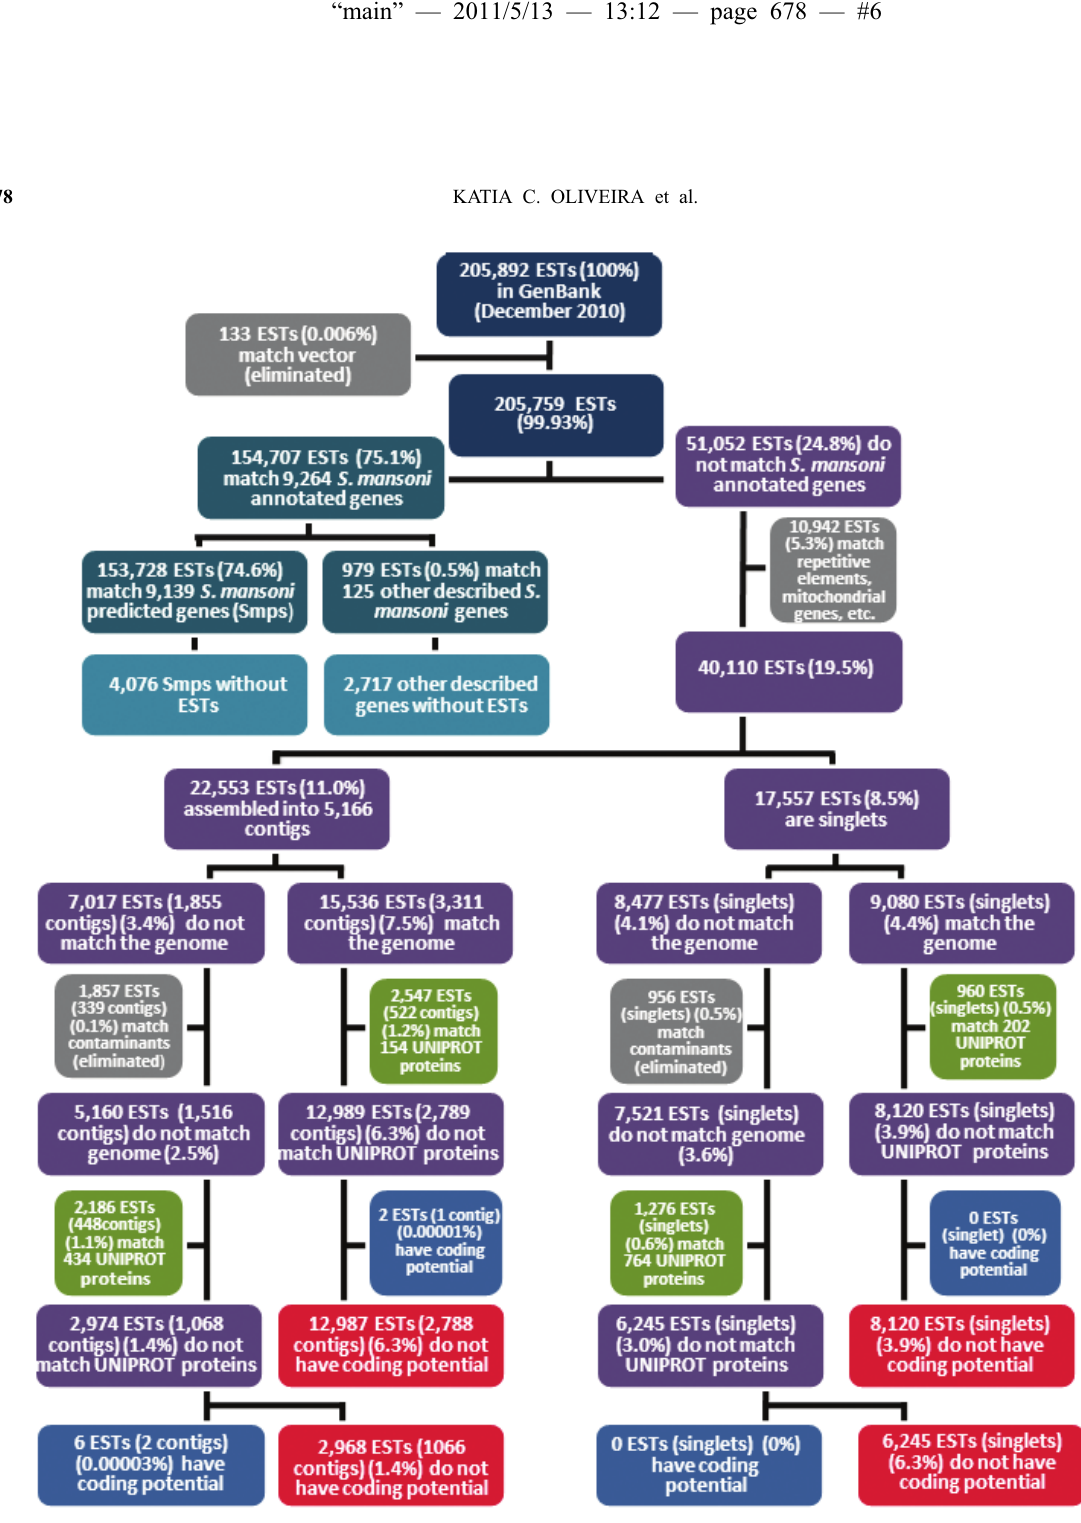
Fig. 2 – Workflow of the genome mapping and annotation of S. mansoni ESTs available in